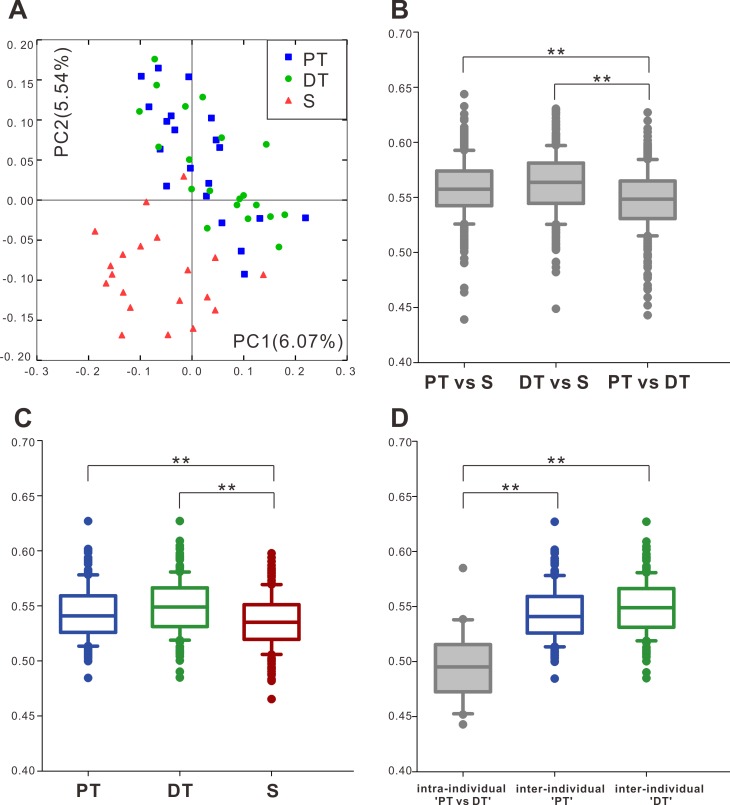
Beta diversity of microbial communities of permanent teeth plaque (PT), deciduous teeth plaque (DT), and saliva (S) based on the unweighted UniFrac distances.(A). Principal coordinate analysis (PCoA). (B). Between-group dissimilarities in the microbial community structures. (C). Within-group dissimilarities of PT, DT, and S. (D). The beta diversities between different sample types from the same child (intra-individual 'PT vs DT') are smaller than those between the same sample types from different child (inter-individual 'PT' and 'DT'. ** P < 0.01 by Kruskal—Wallis test and a Dunn-Bonferroni test for post hoc comparisons. In B, C and D, the boxplots show the medians and the 10th, 25th, 75th, and 90th percentiles of each sampled group.